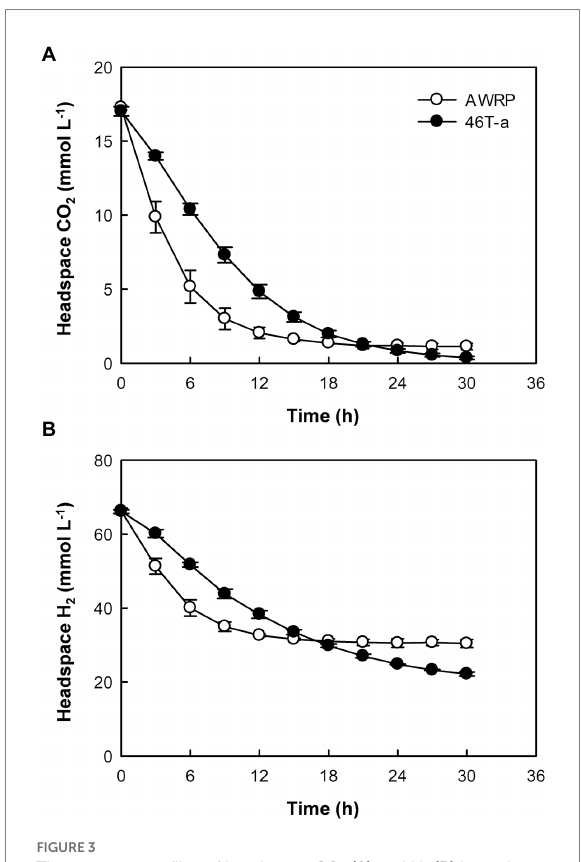
FIGURE 3 Time-course profiles of headspace CO 2 (A) and H 2 (B) in resting cell assay using cells of strains AWRP (open symbols) and 46 T-a (closed symbols). For each strain, assays were conducted in triplicate using medium without yeast extract and average values are presented. Error bars represent one standard